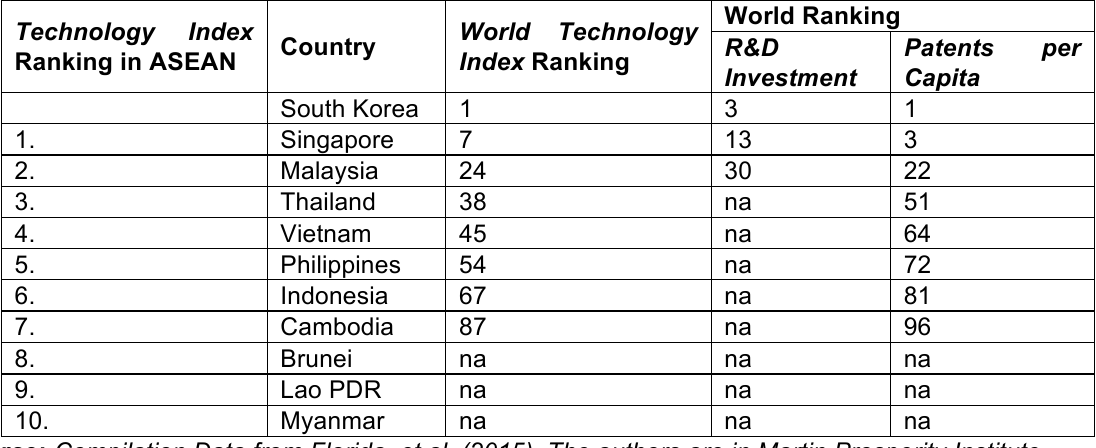
Table 5: Global Technology